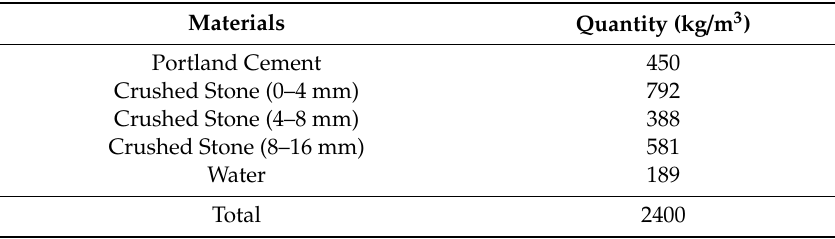
Table 16. Reference concrete material quantities.